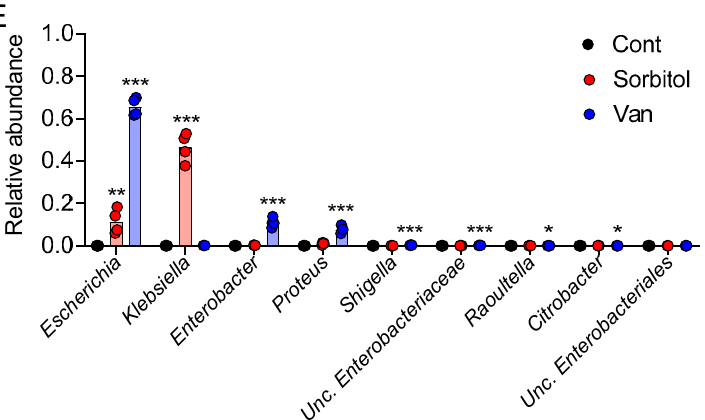
Figure 2. Identification of Enterobacteriaceae as Gut Bacteria Responding to Sorbitol. ( A ) Principal coordinate analysis (PCoA) plot generated using an unweighted UniFrac metric. Amp, ampicillin; Stm, streptomycin; Van, vancomycin; Ery, erythromycin. * p < 0.05 by PERMANOVA t -test. ( B ) Relative abundance of operational taxonomic units (OTUs) in fecal samples from C57BL/6J mice untreated or treated with antibiotics. The various colors correspond to each bacterial order indicated. Amp, ampicillin; Stm, streptomycin; Van, vancomycin; Ery, erythromycin. ( C ) Relative abundance of OTUs in fecal samples from sorbitol-treated C57BL/6J mice ( n = 4). The various colors correspond to each bacterial order indicated. Cont, control; 5%, 5% sorbitol; 10%, 10% sorbitol. ( D ) Relative abundances of OTUs assigned to the family Enterobacteriaceae. Cont, control; 5%, 5% sorbitol; 10%, 10% sorbitol. Each dot represents an individual mouse and the horizontal bars indicate mean values. * p < 0.05, *** p < 0.001 compared with the control group using Dunnett’s t -test. ( E ) Relative abundances of OTUs assigned to the genera of the family Enterobacteriaceae. Bars in the graph are mean values. Each circle represents an individual mouse. * p < 0.05, ** p < 0.01, *** p < 0.001 compared to the Cont group using Steel’s test. Cont, control; Amp, ampicillin; Stm, streptomycin; Van, vancomycin; Ery,